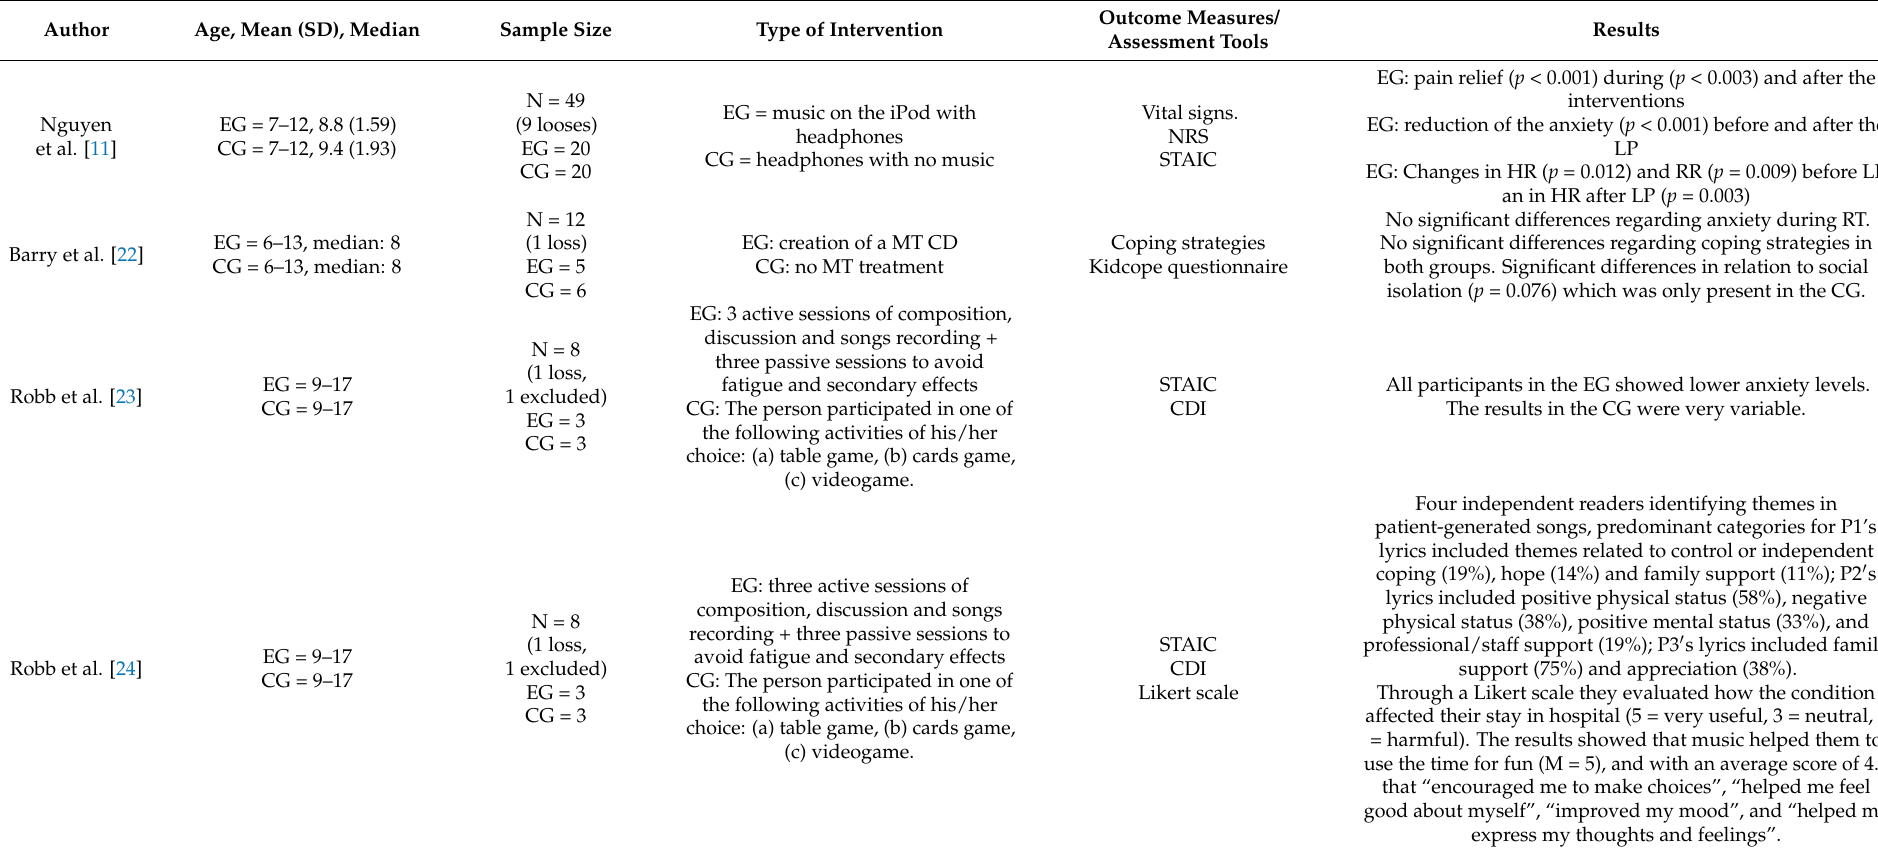
Table 1. Main characteristics of the